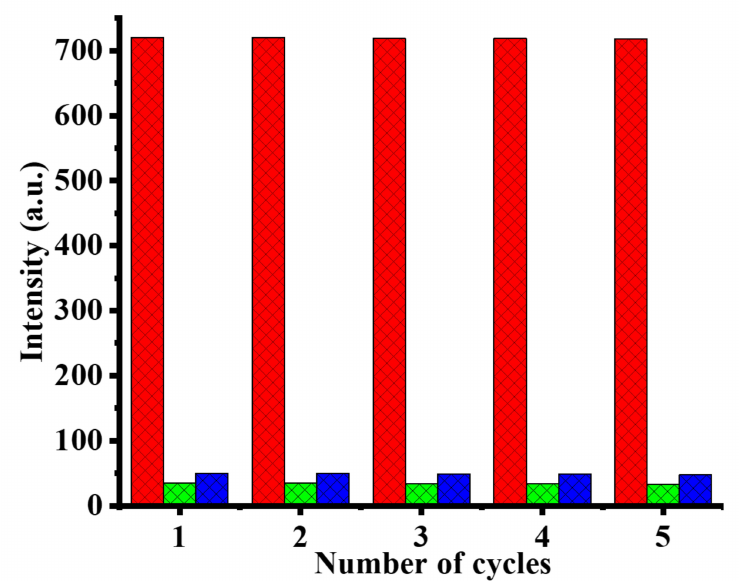
Figure 13. Photoluminescence intensity of 1 in five recyclable experiments for the Fe 3+ and Cr 2 O 7 2 − in aqueous solution (the red bar shows the initial fluorescence intensity; the green bar shows the intensity upon addition of distilled water of 1 mM Fe 3+ ion; and the blue bar shows the intensity upon addition of distilled water of 1mM Cr 2 O 7 2 −